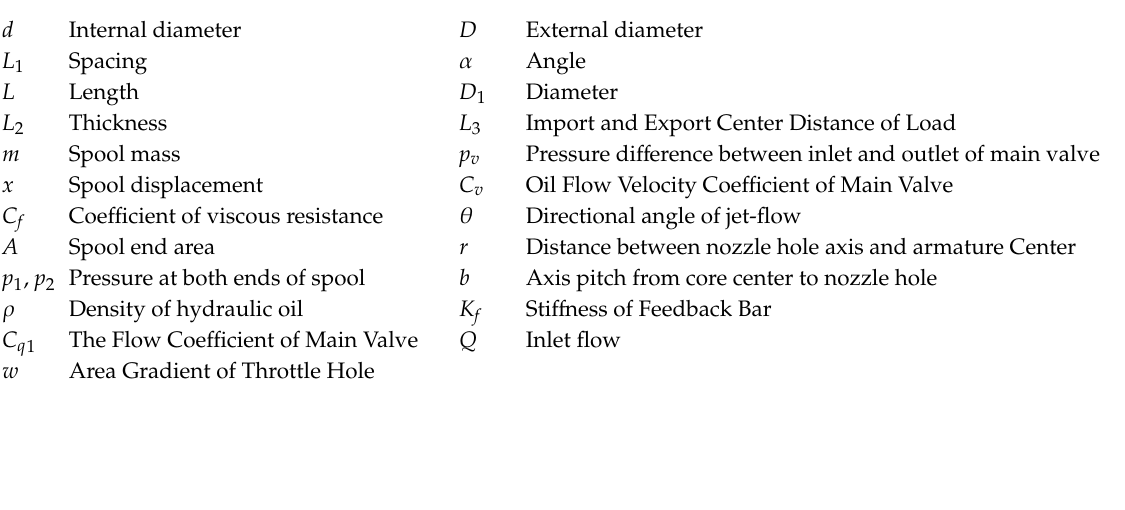
Figure 28. Pressure and main frequency of the flapper when the actual distance between the flapper and nozzle